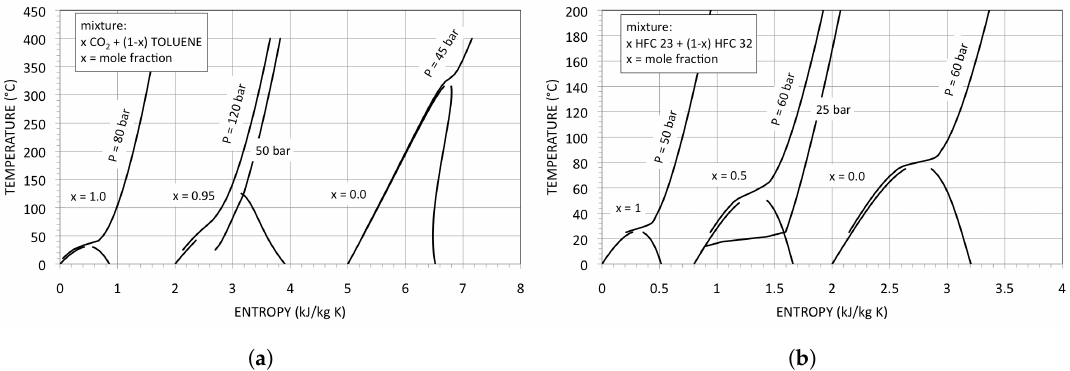
Figure 12. Bubble and dew lines for some pure fluids and their mixtures in the T–S plane. ( a ) Carbon dioxide, pure toluene and a mixture composed by 95% of carbon dioxide (molar composition). The binary interaction coefficients for the used equation of state are from the data bank of Aspen Plus; ( b ) Refrigerant 23 and refrigerant 32. The binary interaction coefficients are from